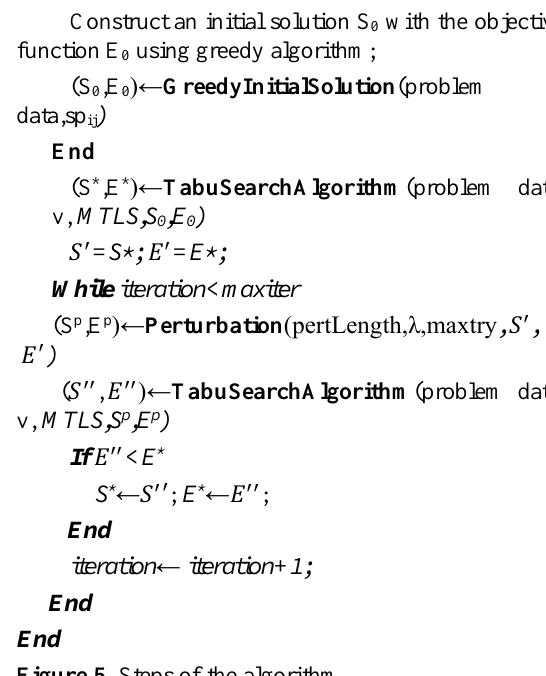
Table 6. Response table of S/N